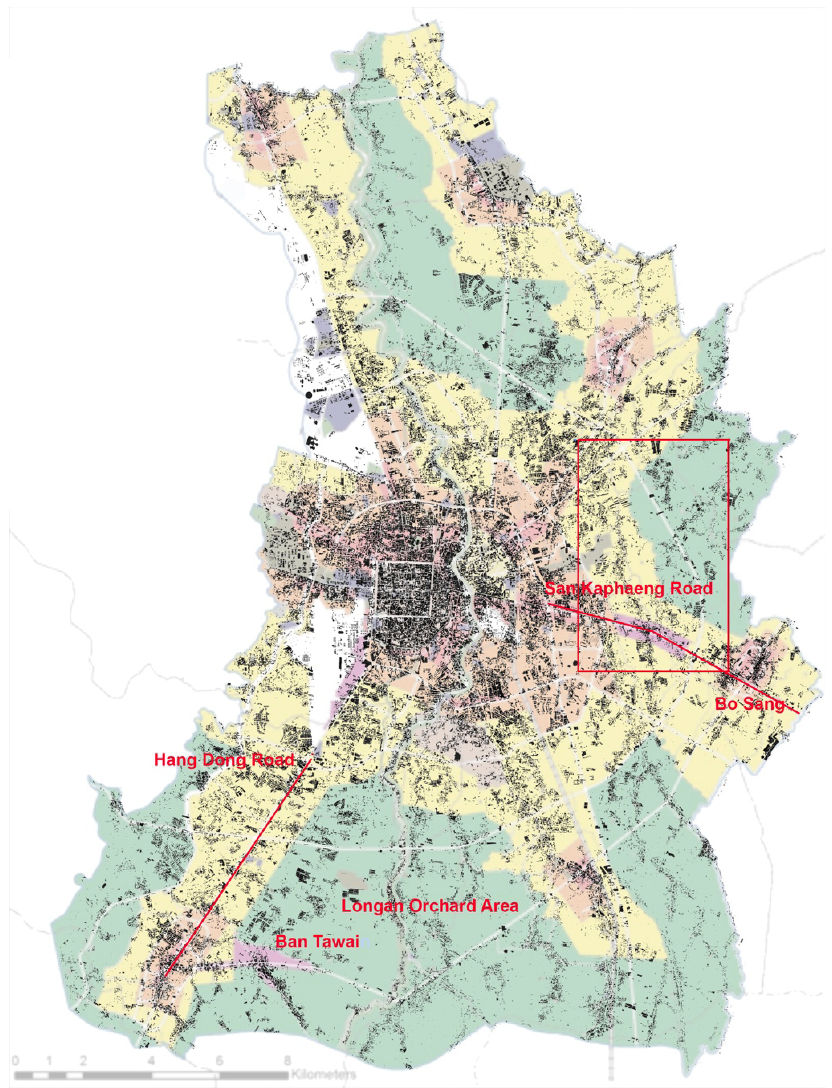
Figure 8. Figure/Ground drawing of Chiang Mai overlaid on the comprehensive plan area showing the highway induced sprawl overlaying with the existing village/water/paddy structure of the land. Both growing villages and new gated en- claves proliferate within the agricultural preservation zone (green on this map). The inset area outlined in red is the study area illustrated in Figure